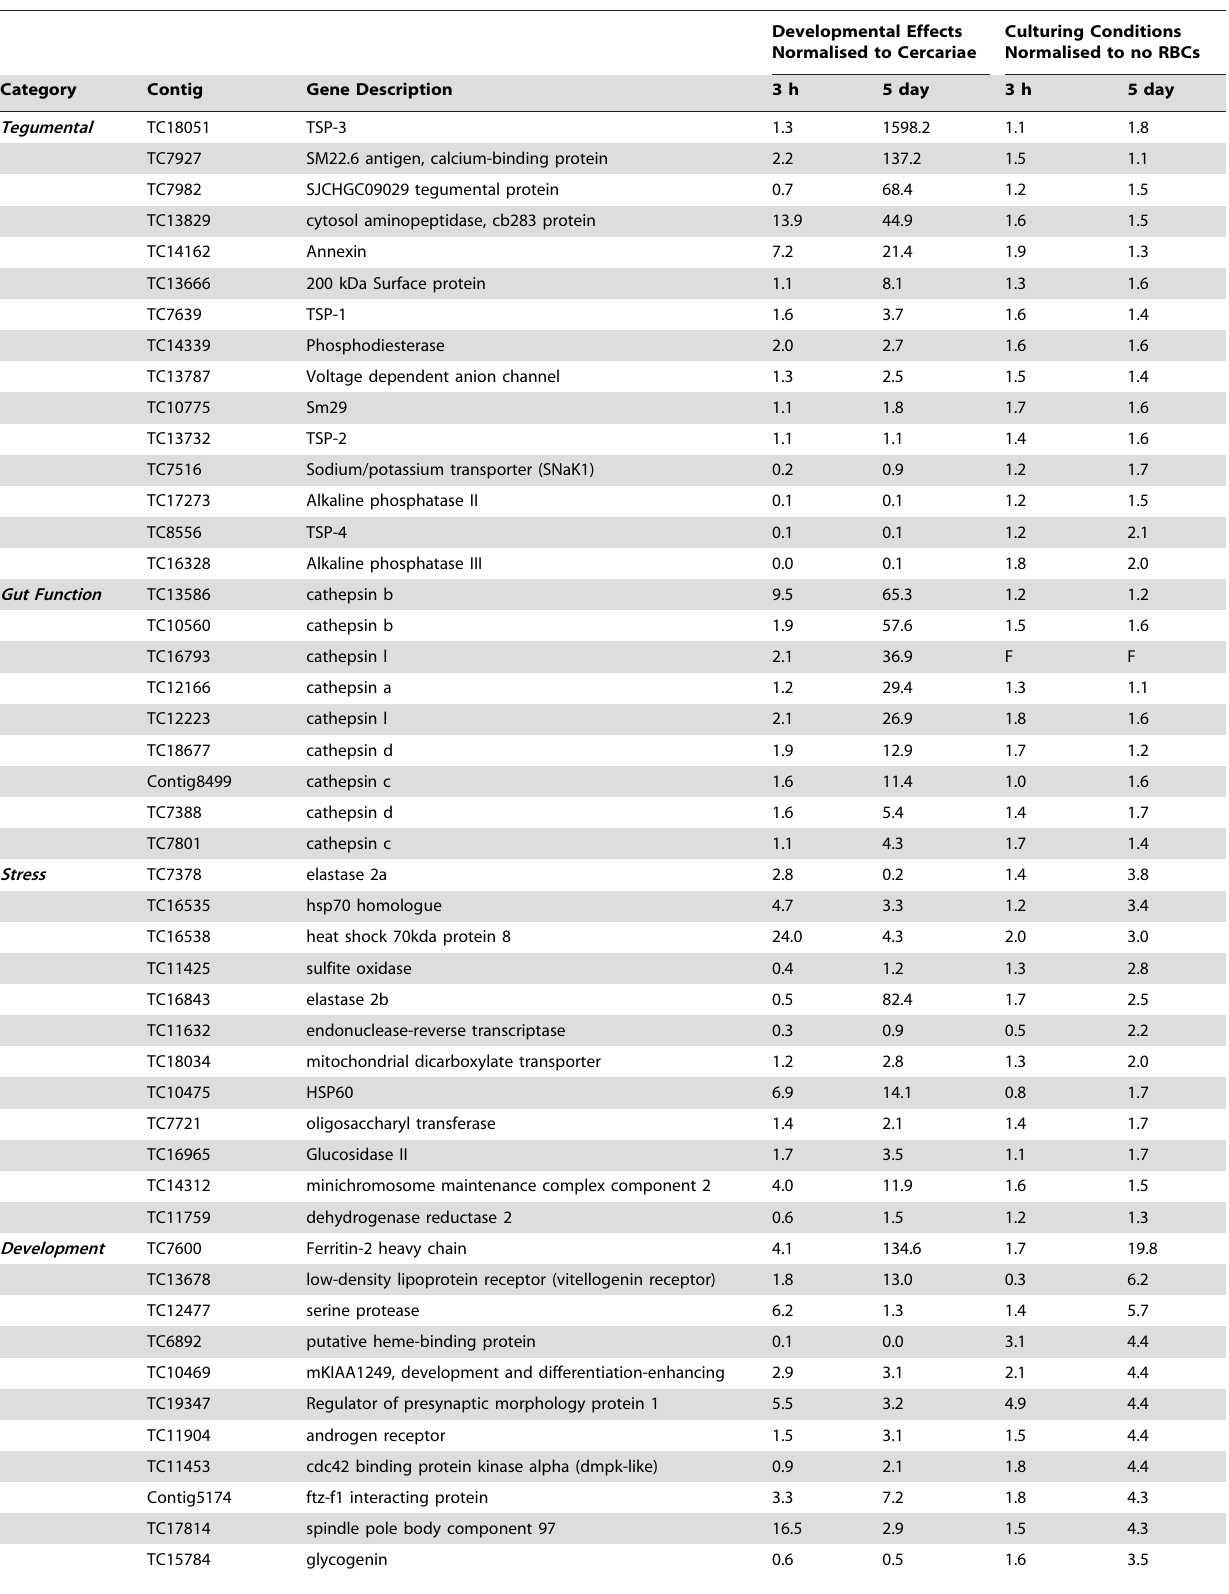
Table 1. Examples of selected genes during the development of 3 h and 5 day schistosomula of S. mansoni .